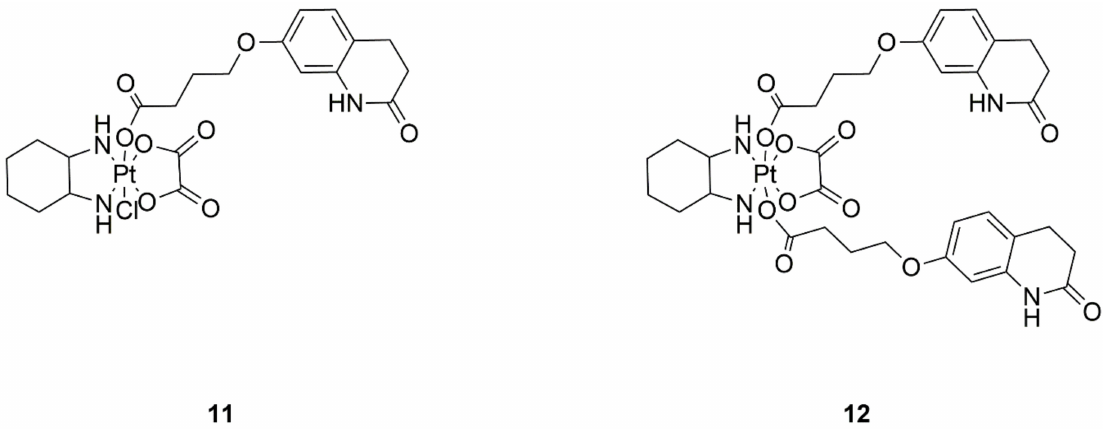
Figure 3. Structures of the new complexes of platinum(IV) with dihydro-2-quinolone—( 11 ) mono DHQLO oxaliplatin and ( 12 ) dual DHQLO oxaliplatin